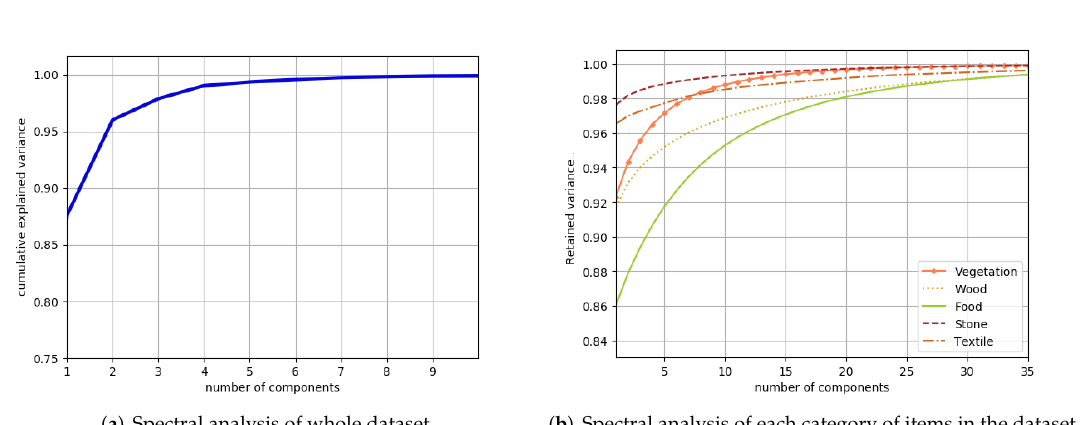
Figure 12. Number of components (x-axis) required to retain the variance percentage (y-axis). ( a )